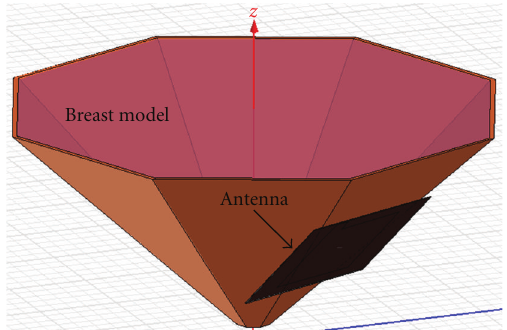
Figure 6: Simulation model in HFSS showing the breast and the antenna.